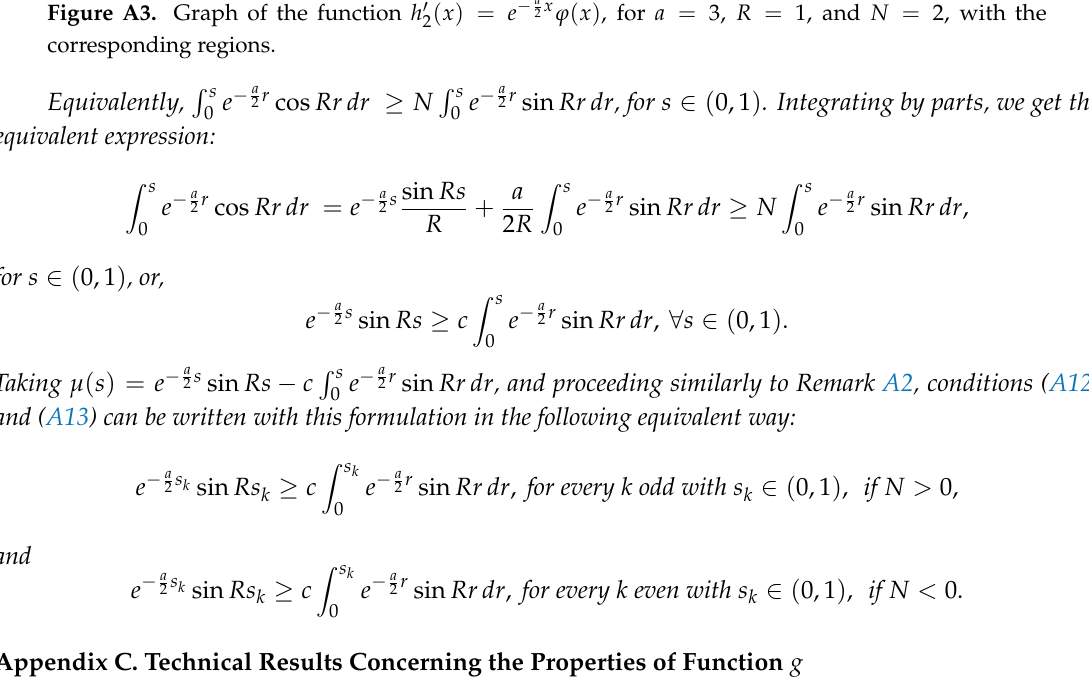
( x ) = e − a 2 x ϕ ( x ) , for a = 3, R = 1, and N = 2, with the 2